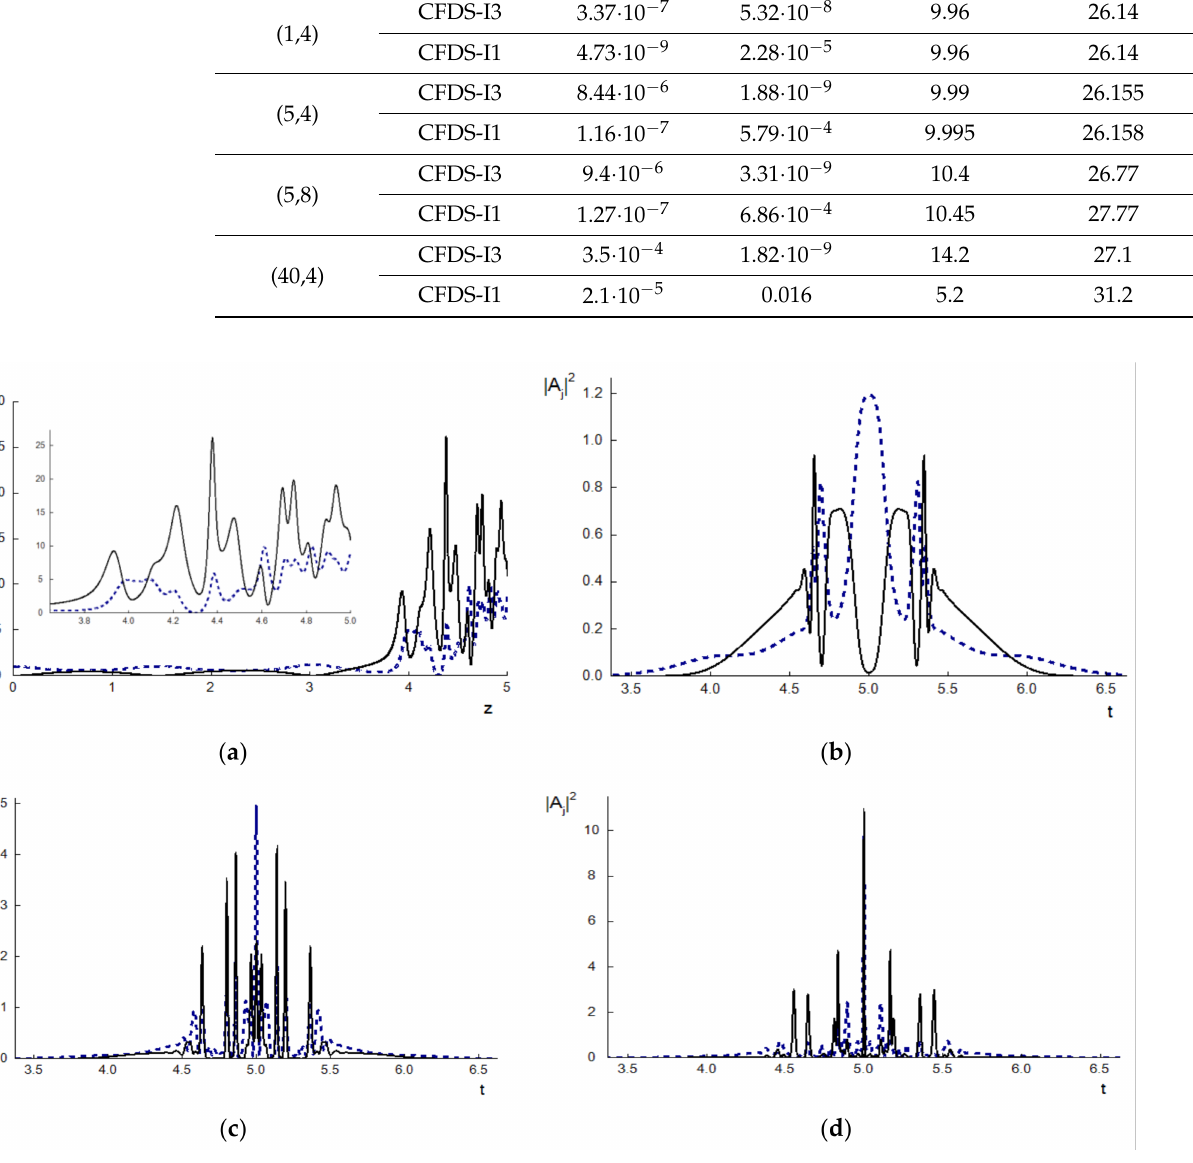
Figure 1. The intensity evolution at the pulse center ( t = 0.5 L t ) ( a ) and pulse shapes in sections z = 3 ( b ), 4 ( c ), 5 ( d ) for the BW (dashed line) and TH (solid line)